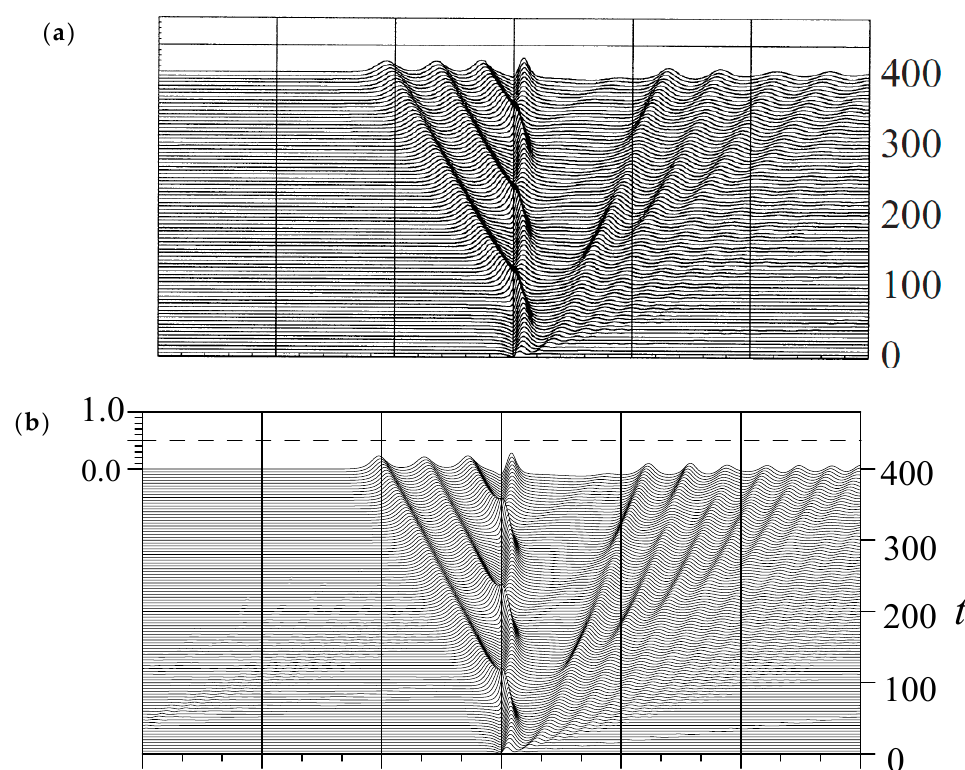
Figure 4. Processes of a typical time step of convergence iterations for the primary variables.